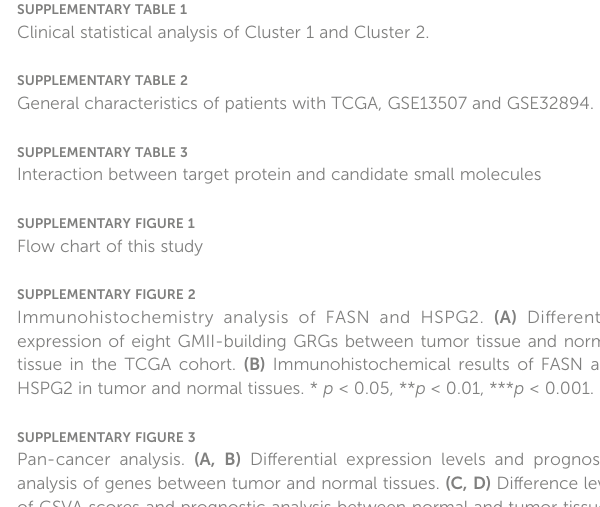
SUPPLEMENTARY TABLE 1 Clinical statistical analysis of Cluster 1 and Cluster 2.